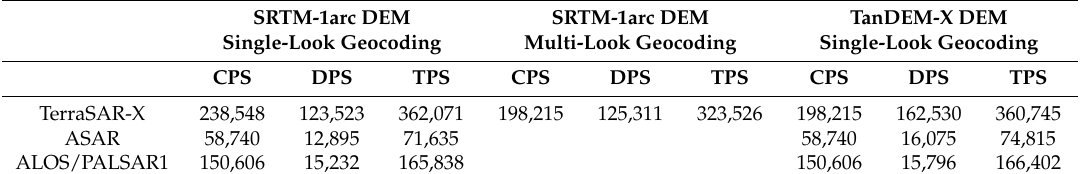
Table 1. Number of selected PSs for the three platforms with two different external DEMs.